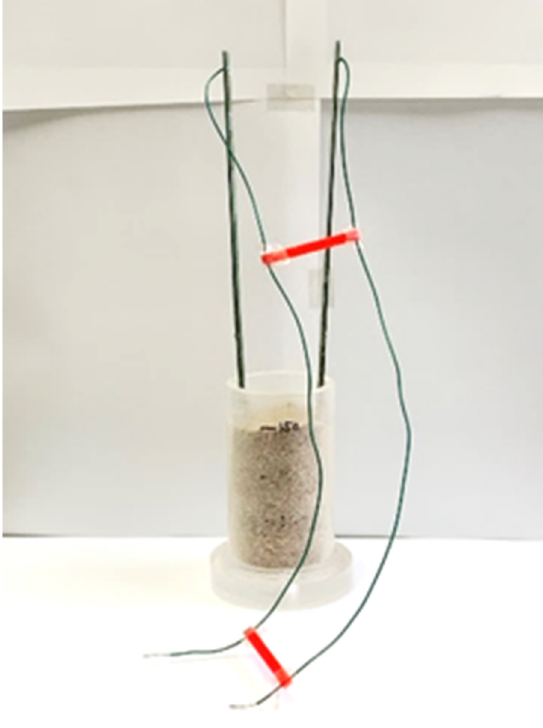
Figure 24. Measurement of the ion concentration in soil.